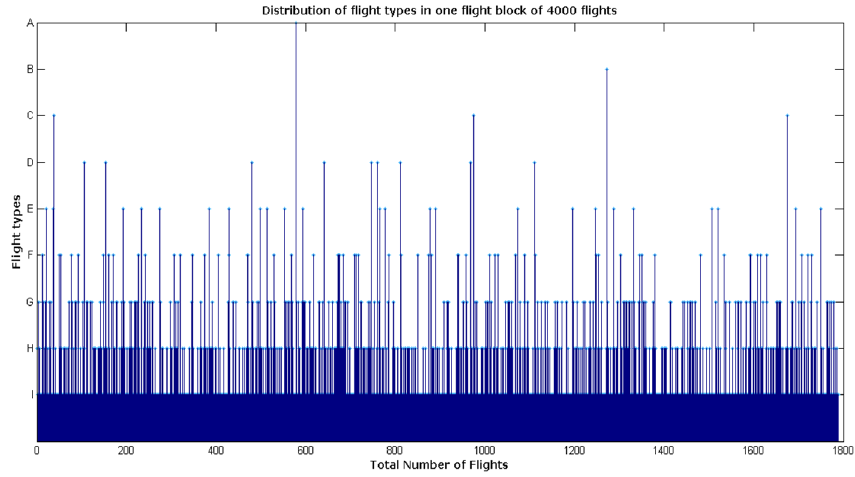
Figure 19. Distribution of flight types in one flight block of 1800 flights (mini-TWIST spectrum).